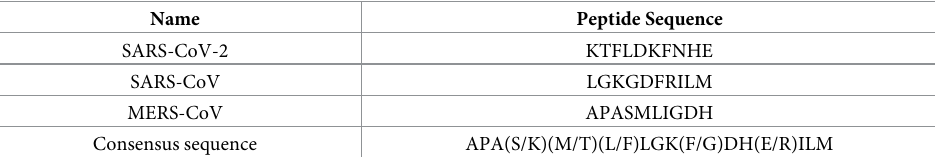
Table 1. Potential peptide sequences that may bind to the